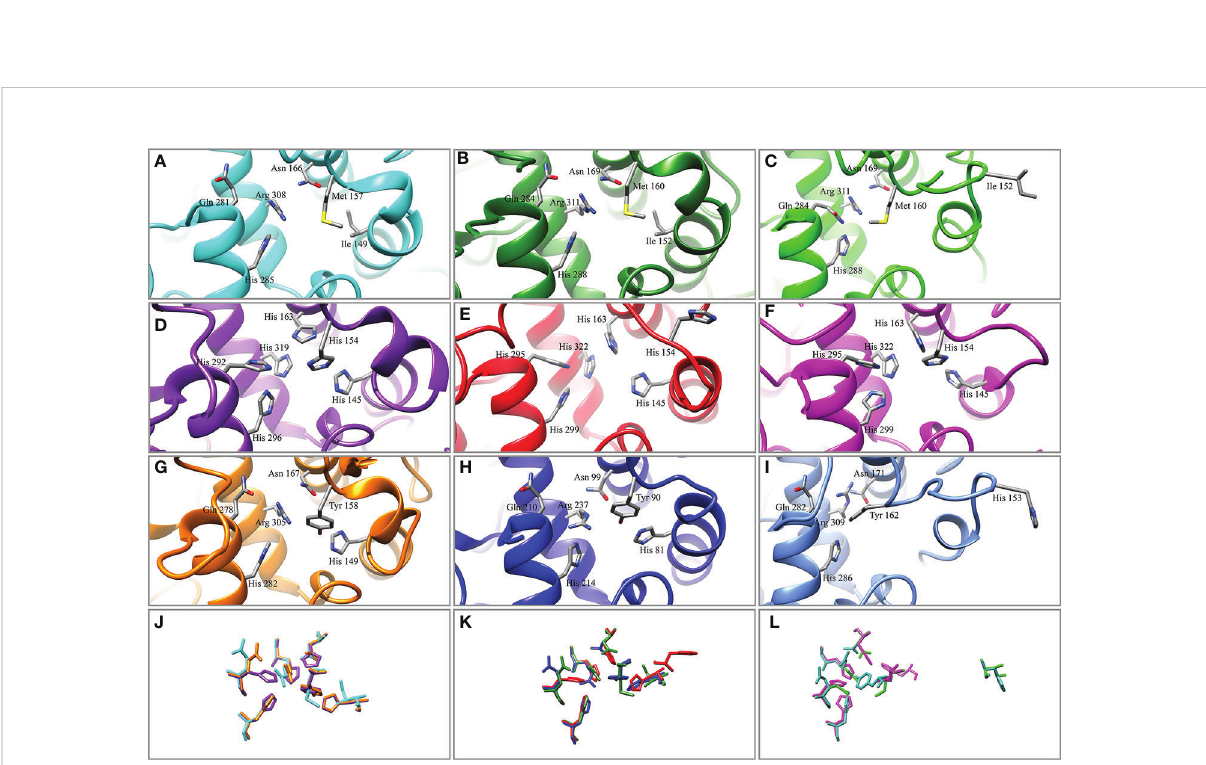
FIGURE 2 Tertiary structure of the copper-binding sites of tyrosinase. (A) PmTyr-4. (B) PmaxTyr-4. (C) PmarTyr-4. (D) Tyrosinase-like protein 1 (BAF42771.1). (E) Tyrosinase B1.1 (AHZ34289.1). (F) Tyrosinase 2 (CCE46152.1). (G) PmTyr-6. (H) PmaxTyr. (I) PmarTyr. (J) Structure comparison of copper-binding sites in (A, D, G) . (K) Structure comparison of copper-binding sites in (B, E, H) (L) Structure comparison of copper-binding sites in (C, F, I) .